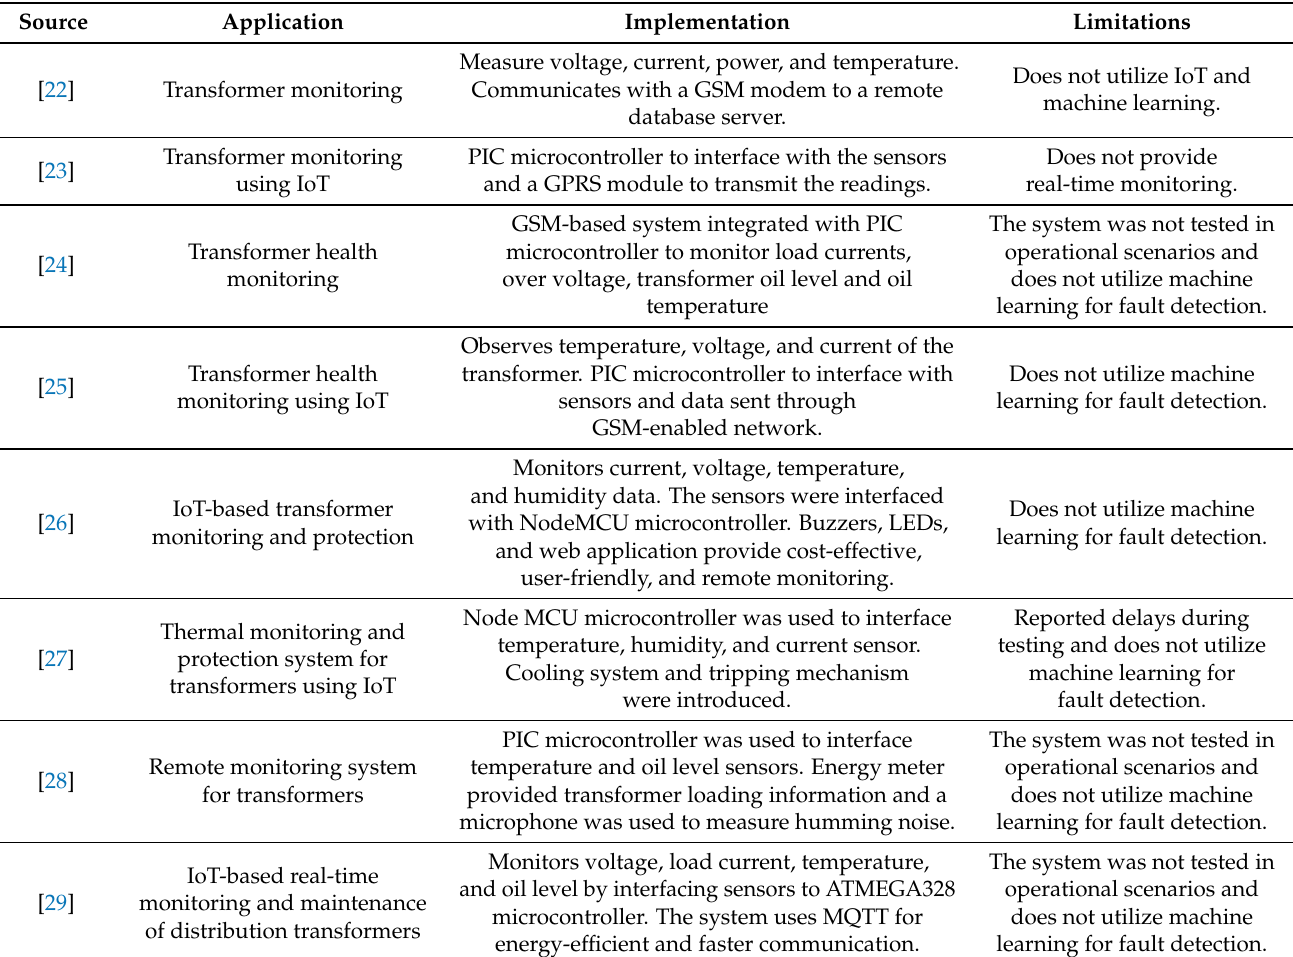
Table 1. Summary of recent literature focusing on smart transformer monitoring and